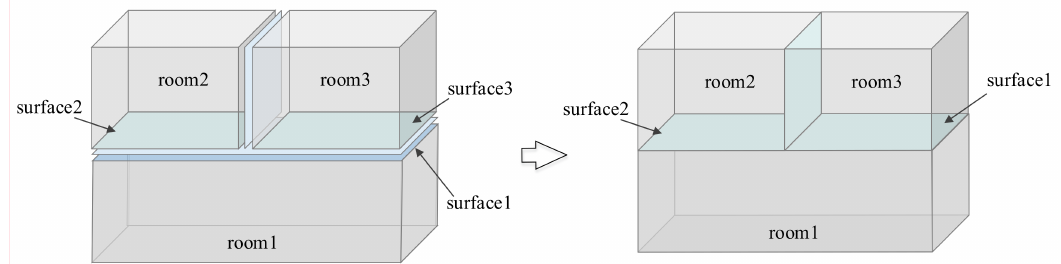
Figure 12. ( a ) Sectional drawing of a building. ( b ) Simplification of roofs and ground plates.